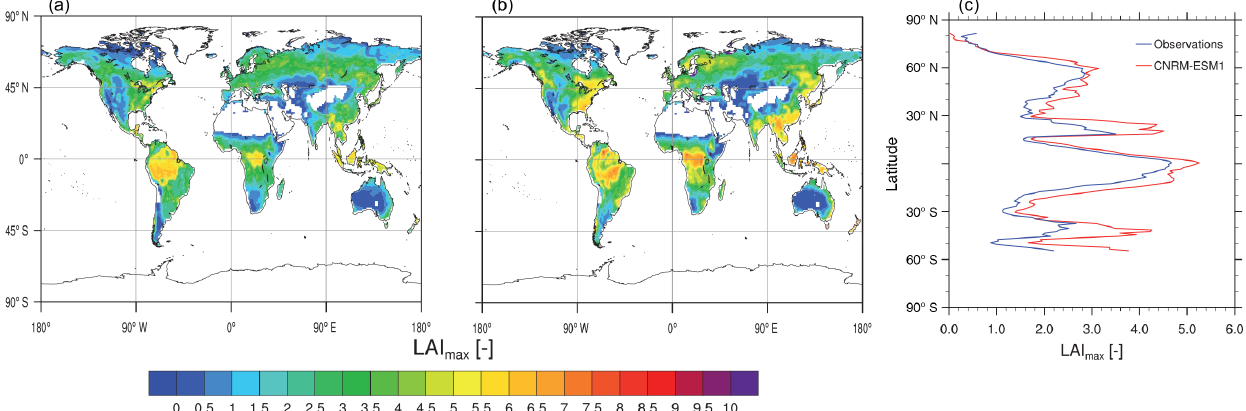
Figure 17. Composite of yearly maximum of leaf area index (LAI max ) as estimated from AVHRR satellite observations of Zhu et al. (2013) (a) and as simulated by CNRM-ESM1 (b) over 1986–2005. Panel (c) represents the zonal-average LAI max in function of latitude for both observation-based estimates (in blue) and CNRM-ESM1 (in red).